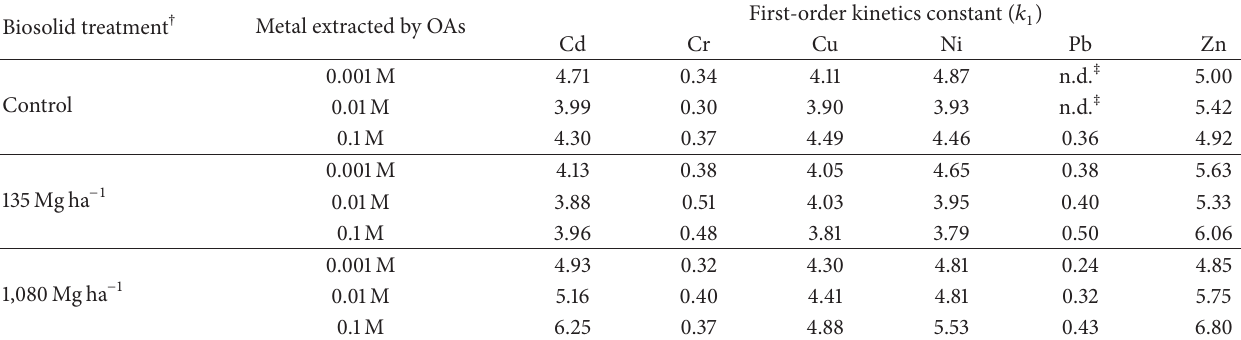
Table 13: First-order kinetics constant for metal dissolution reaction extracted by organic acid (OA) mixtures according to (3). Biosolid treatment † Metal extracted by OAs Cd 0.001 M Control